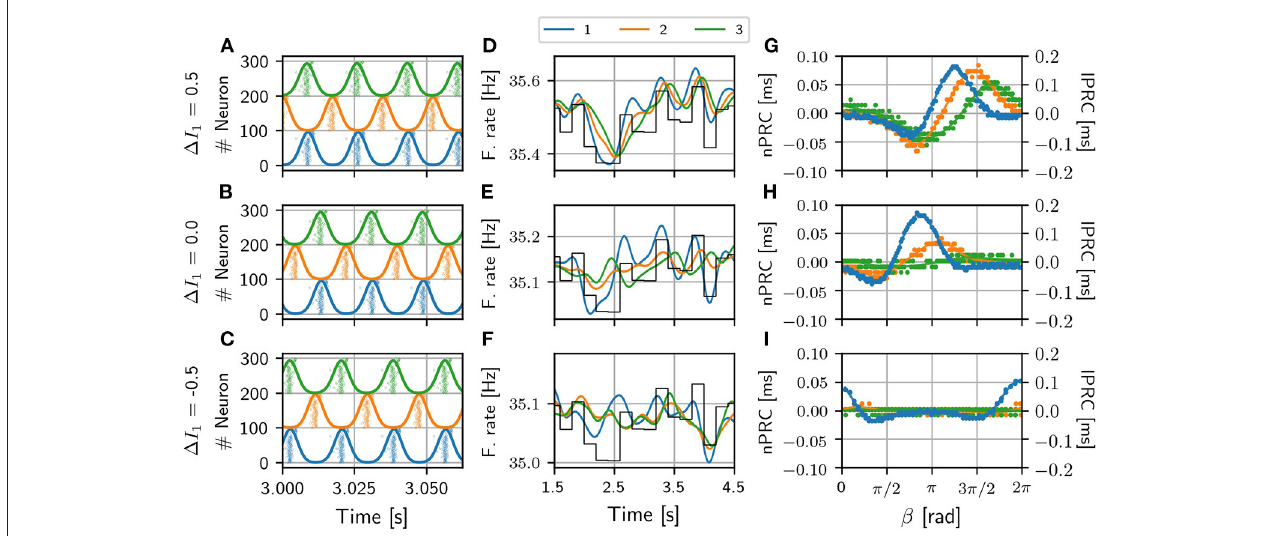
FIGURE 3 | V-motif. Examples of the activity of the three populations and their corresponding firing rate for different values of 1 I in the absence of an external signal (A–C) . Examples of firing rates of the three populations for different values of the frequency mismatch 1 I when a slow arbitrary signal (black line, arbitrary units) is applied to population 1 (D–F) . Examples of local and non-local phase response curves of the sender and receiving populations, respectively, for the same different values of frequency mismatch 1 I when a fast pulsating signal is applied in population 1 (G–I) . Note that the scale of lPRC and nPRC are different for a better visualization. Delay τ = 6 ms in all